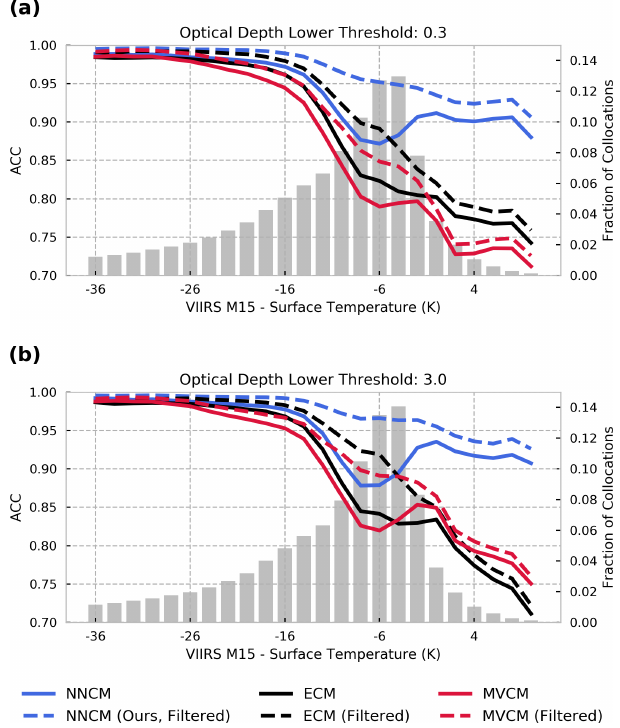
Figure 10. ACC calculated as a function of thermal contrast with the surface approximated by the difference between VIIRS M15 (10.8µm) and surface temperature in Kelvin. Each subplot repre- sents a set of collocations consisting of clear-sky scenes and cloudy scenes with optical depths greater than 0.3 (a) and 3.0 (b)